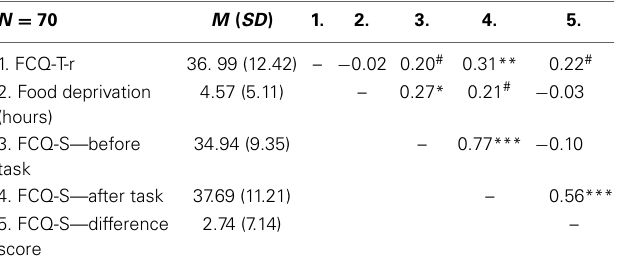
Table 4 | Descriptive statistics of state variables in study 2 and correlations with the Food Cravings Questionnaire—Trait—reduced (FCQ-T-r).